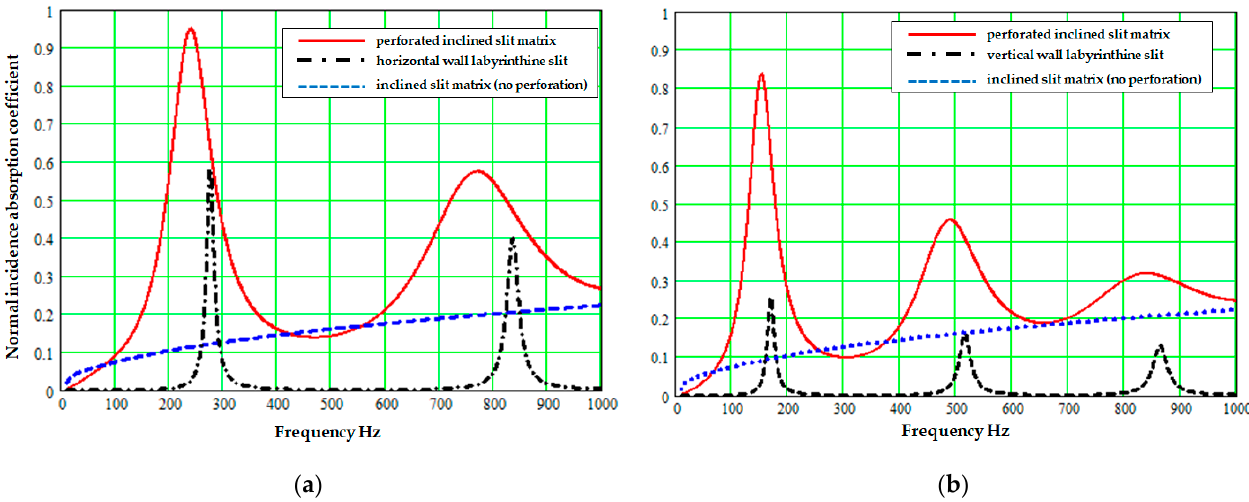
Figure 4. Normal incidence absorption spectra predicted for a 5 cm thick hard-backed inclined slit matrix (0.04 mm wide slits at 70 ◦ to the normal, porosity 0.9) with (solid lines) and without (dotted lines) ( a ) a horizontal-wall labyrinthine slit perforation ( w = 2 mm, b = 4 mm, l = 40 mm, N = 8) and ( b ) a vertical-wall labyrinthine slit perforation ( w = 1 mm, b = 3 mm, l = 45 mm, N = 10). The dash-dot lines represent predictions for the labyrinthine slit perforations in a non-porous solid matrix.